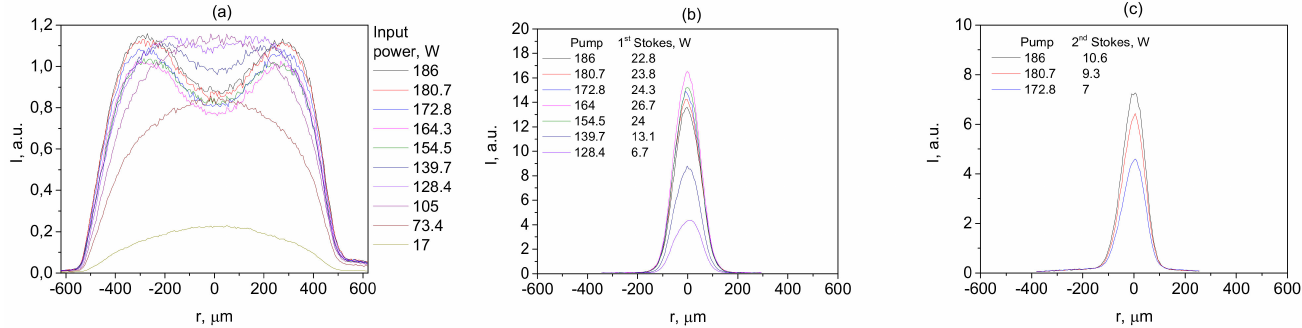
Figure 7. Beam profiles for the transmitted pump beam ( a ) and generated 1st ( b ) and 2nd ( c ) Stokes beams in RRFL cavity configuration as a function of